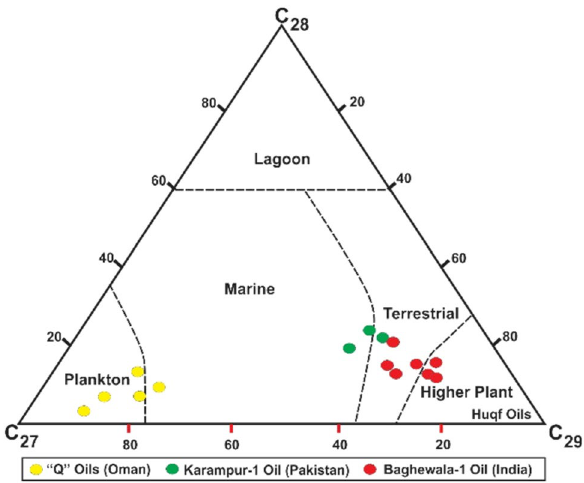
Figure 16. Analysis of the geochemistry of hydrocarbons (oil) in southern Oman ’Huqf’ and ’Q’ oil, Karampur-1 (Pakistan), and Baghewala-1 (India).